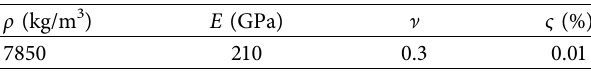
Table 4: Mechanical properties of steel material.